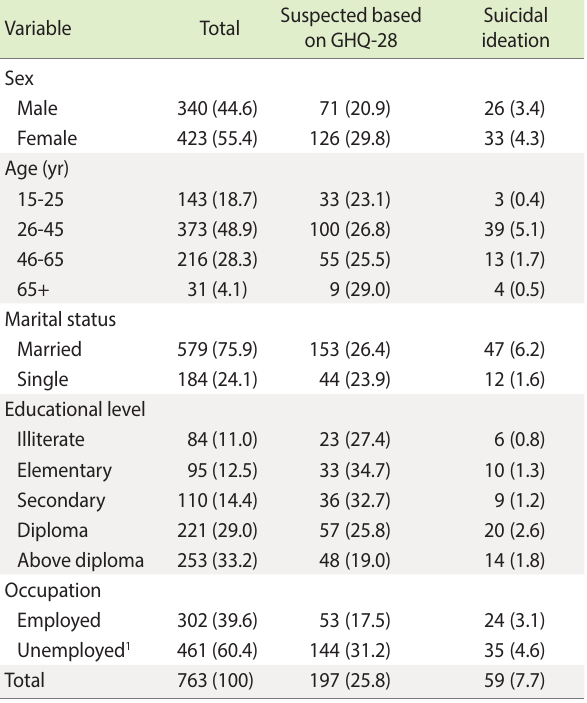
Table 1. Demographic characteristics of persons suspected to have